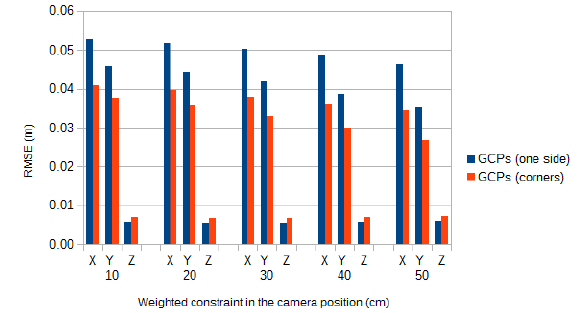
Figure 6. Sensor 1 – RMSE for GCPs resulting from the BBA considering GCPs in the corners and only on one side of the image block.